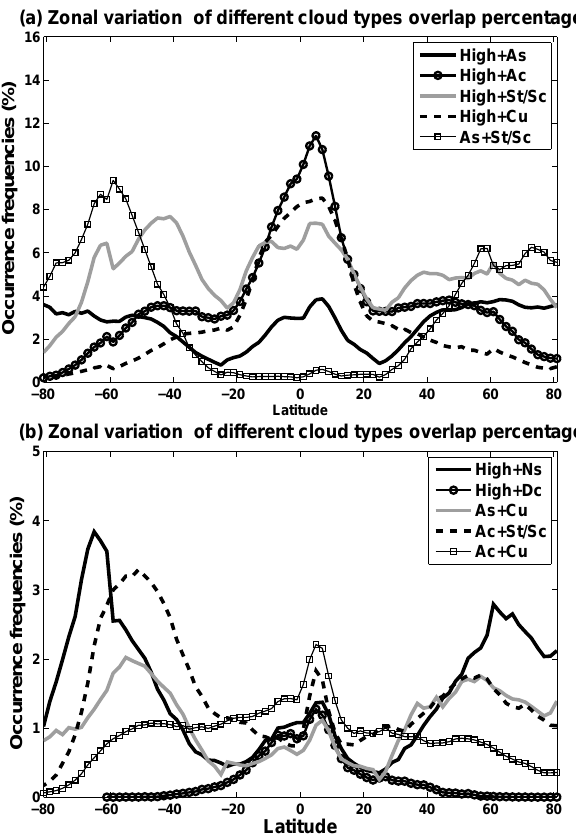
Figure 1. (a) The global distribution (2 ◦ × 2 ◦ grid boxes) of annu- ally averaged multilayered cloud fraction. (b) The zonal distribu- tions of seasonal, averaged multilayered cloud fraction.